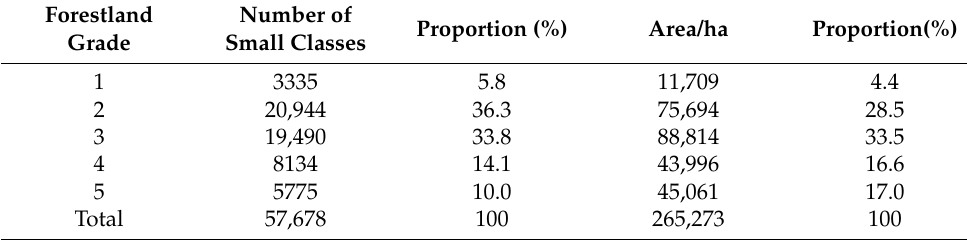
Table 3. Forestland classification results in Longquan